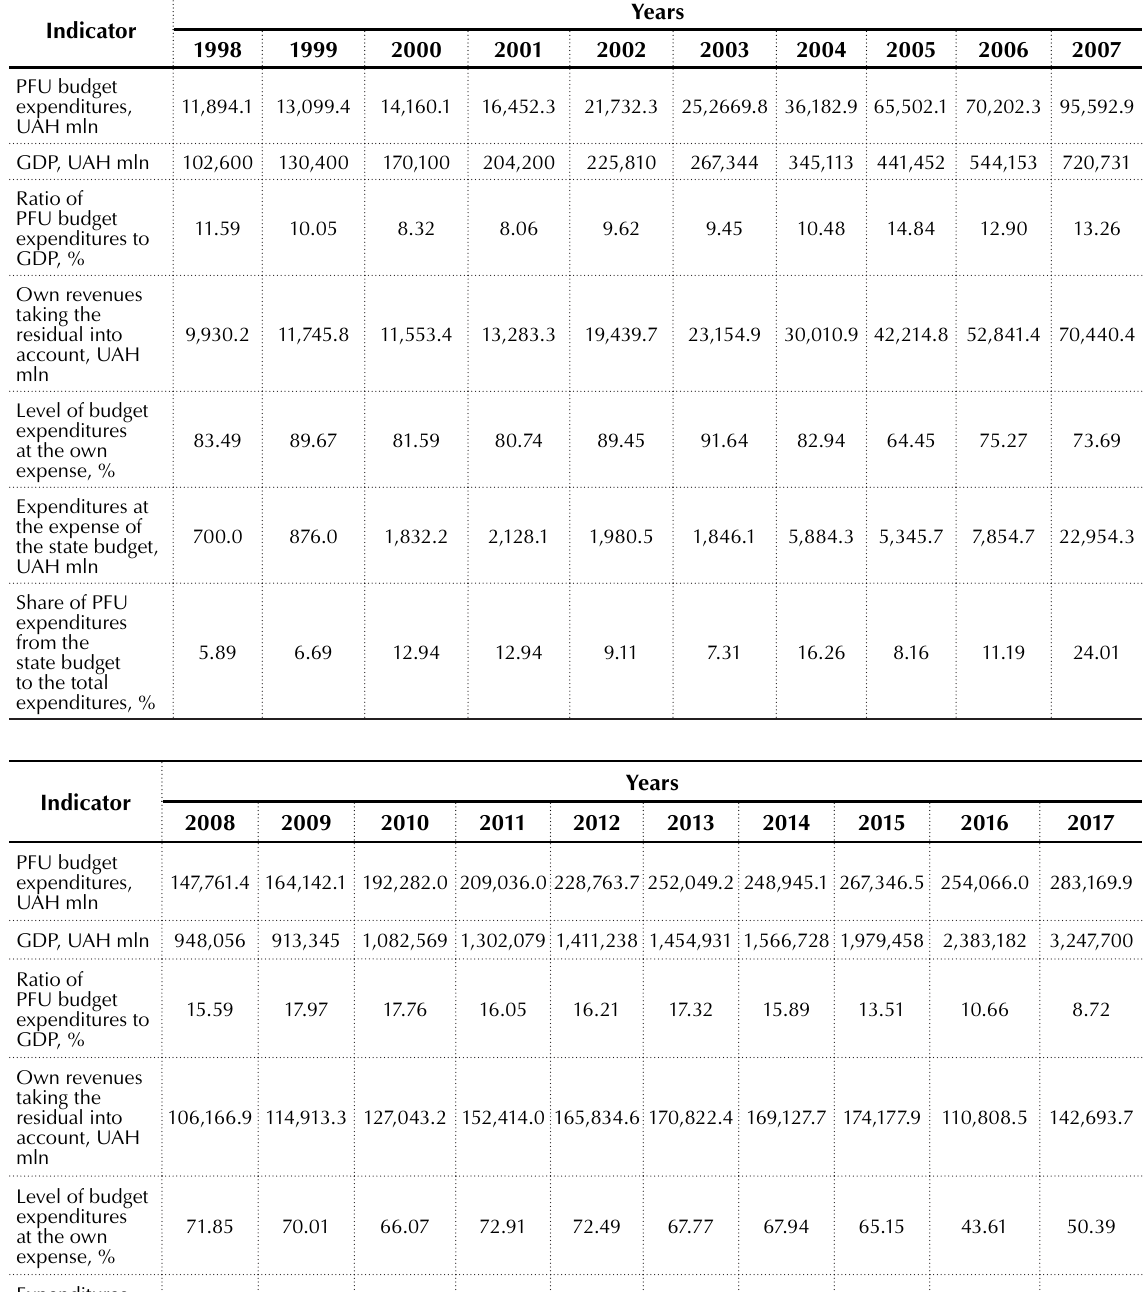
Table 4. Key indicators characterizing the financial provision of the Pension Fund of Ukraine functioning for the period 1998–2017